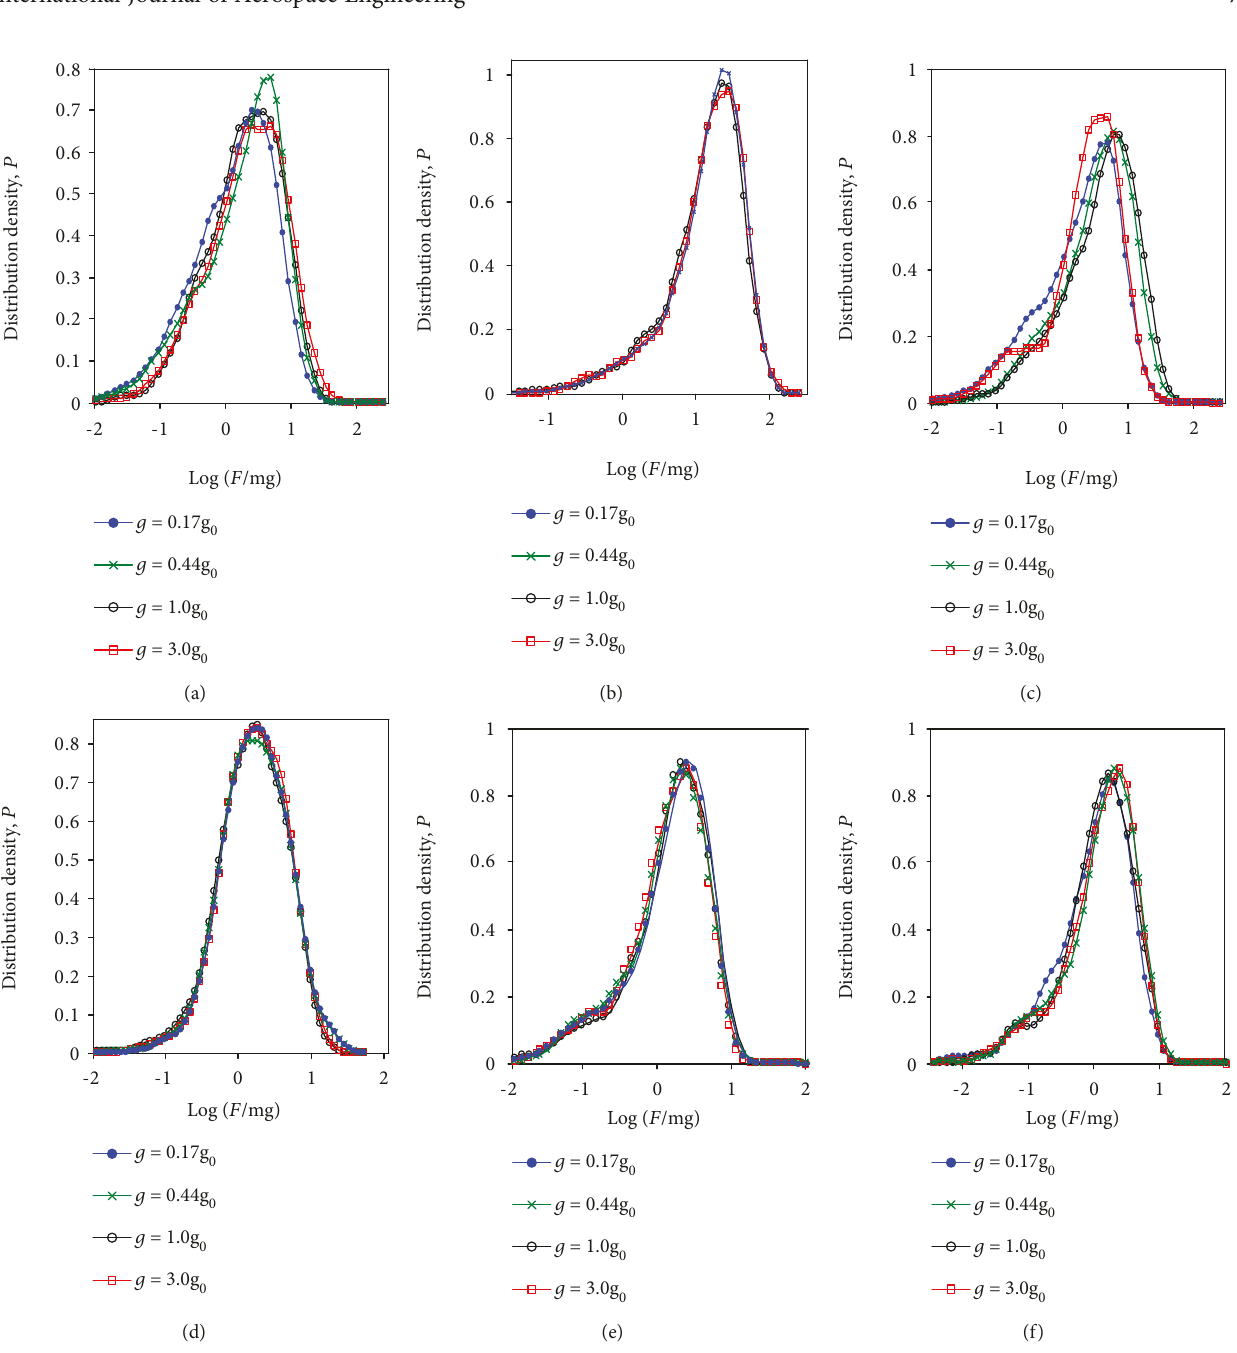
Figure 7: Probability distributions of contact force F in the particulate pile under di ff erent kinds of gravity accelerations for particle samples: , (b) S , (c) S , (d) S , (e) S , and (f) S (a) S n1 n2 n3 lg1 lg2 lg3